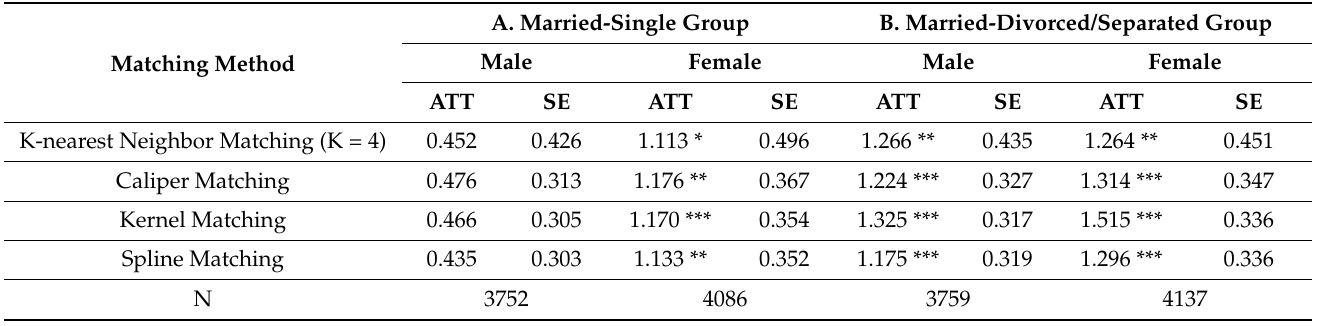
Table 3. The heterogeneous effects of parental